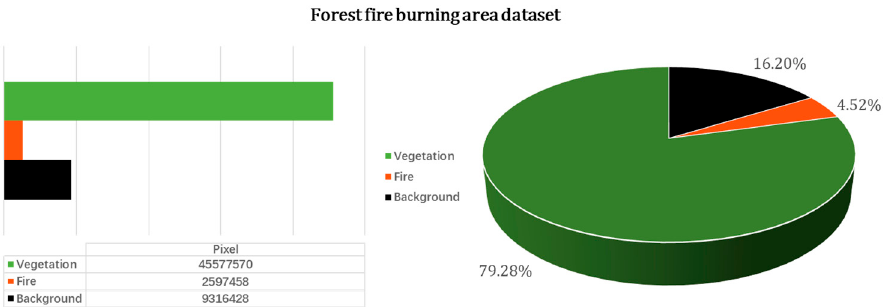
Figure 5. Number and percentage of pixels in each classification sample in the forest fire burning area dataset.